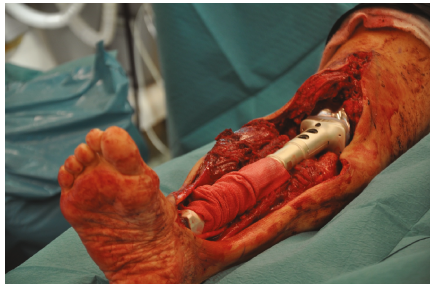
Figure 4: Perioperative image of the total tibia resection and reconstruction. The tibia tumor is totally resected, and the tibia is replaced with a custom-made endoprosthesis. The endoprosthesis was enveloped in a Trevira tube to facilitate the attachment of soft tissues and the patella tendon.